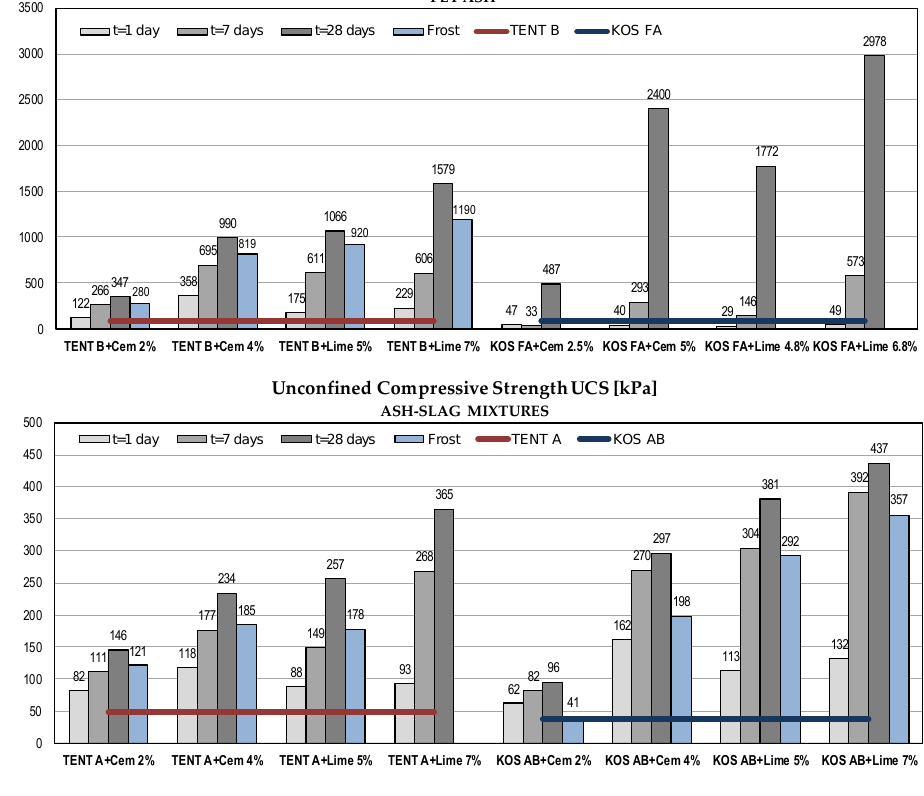
Figure 7. UCS of waste materials with binders.